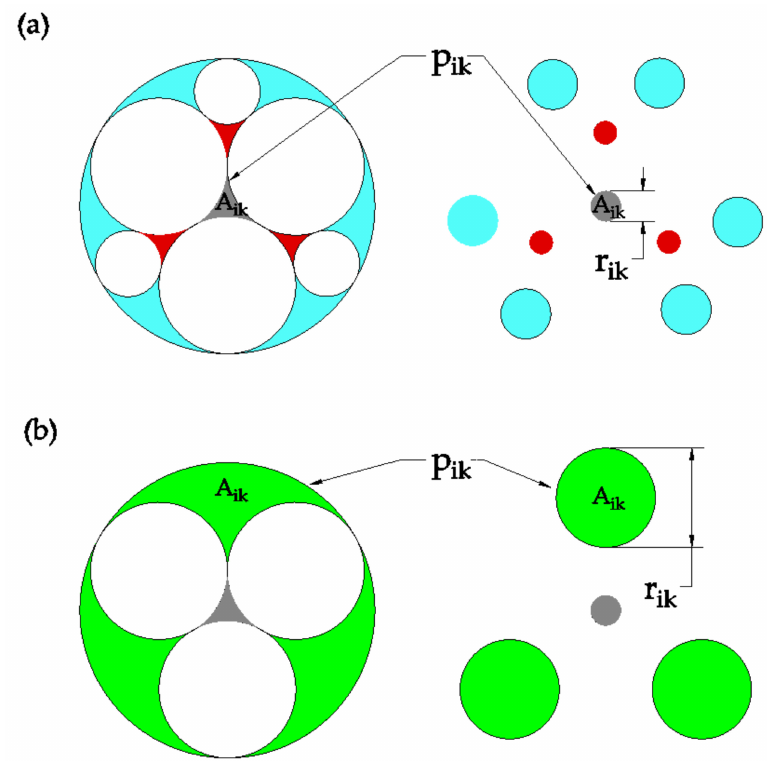
Figure 10. Diagram showing: ( a ) the pore space associated with a maximally filled pore p i , with the area A ik of one subpore p ik highlighted (with k ranging from 1 to 10); ( b ) the pore space associated with a partially filled pore with the area A ik of one subpore p ik highlighted (k ranging from 1 to 4). In both ( a , b ) each subpore p ik is transformed to a circular shape with an equivalent area, and subpores with the same color have identical